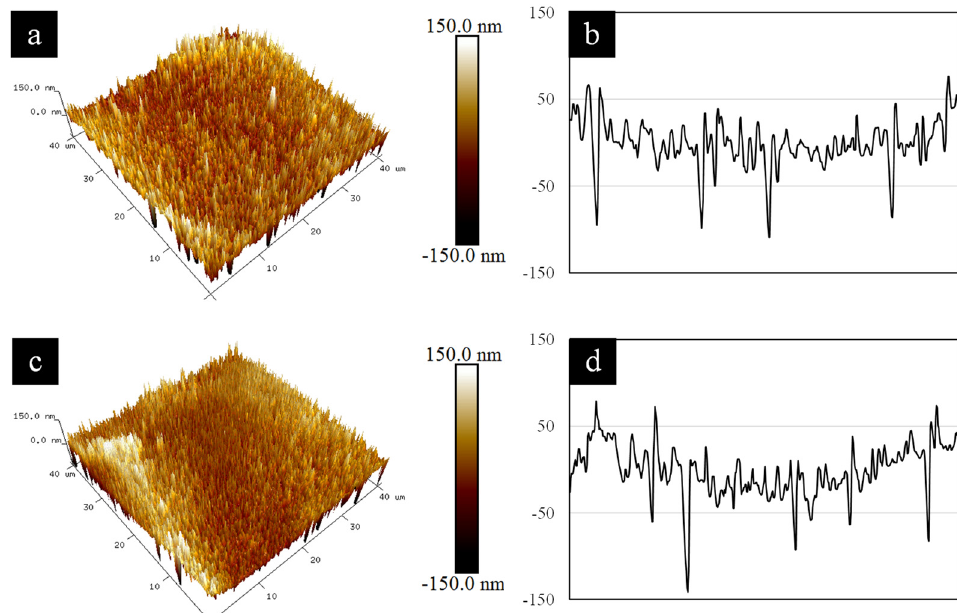
Figure 1. Pseudo − colour 40 µm × 40 µm 3D AFM plots for ( a ) 25PS75PMMA and ( c ) 25PS75PMMA_750 surfaces, (colour scale range ± 150 nm) with corresponding line profiles ( b , d ) generated from xy midpoint.